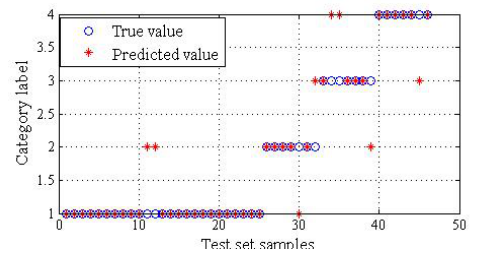
Fig. 13. Prediction results based on BP on ABC-SVM is the